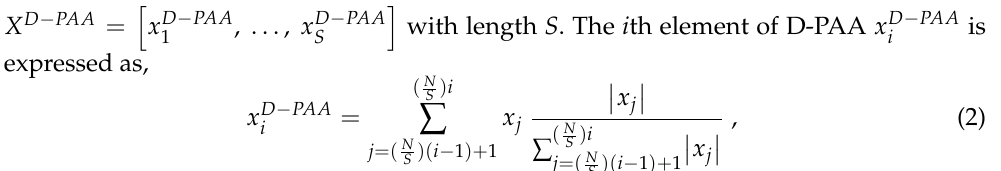
(cid:12) (cid:12) (cid:12) x j (cid:12) is the absolute value of the